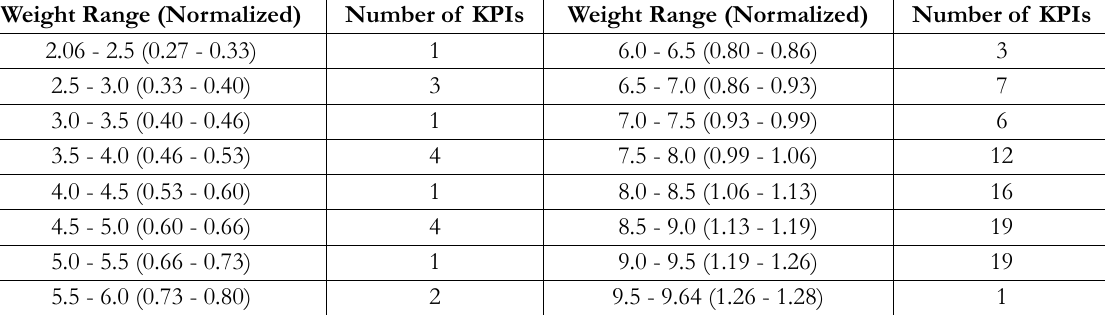
Table 3. Number of KPIs in each of the 16 selected ranges